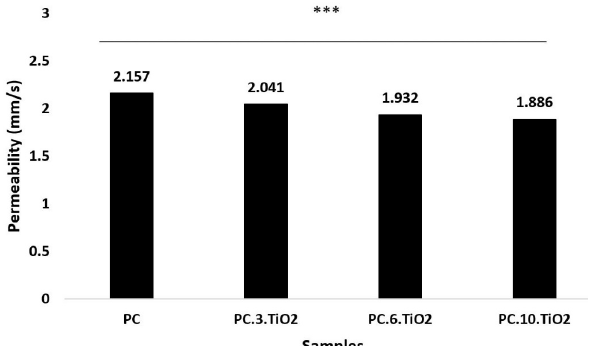
Figure 12 Average of samples obtained in the Permeability test. *** Statistically significant difference by the Tukey test p